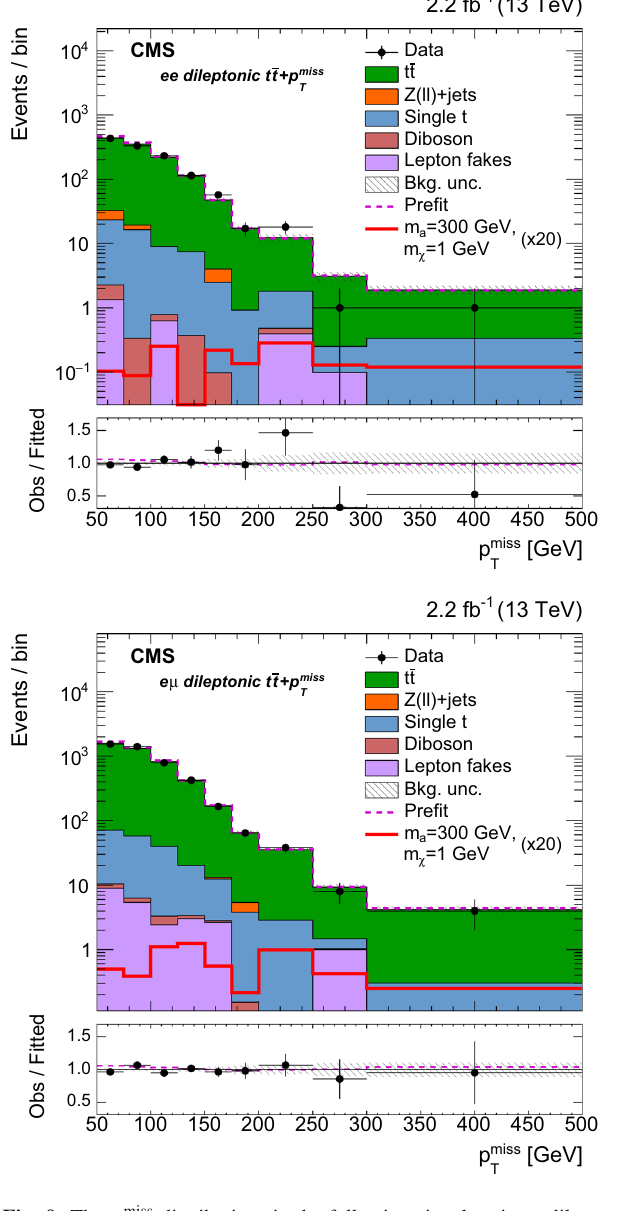
respond to an overall normalization uncertainty for the tt + p miss SRs of 4%. T